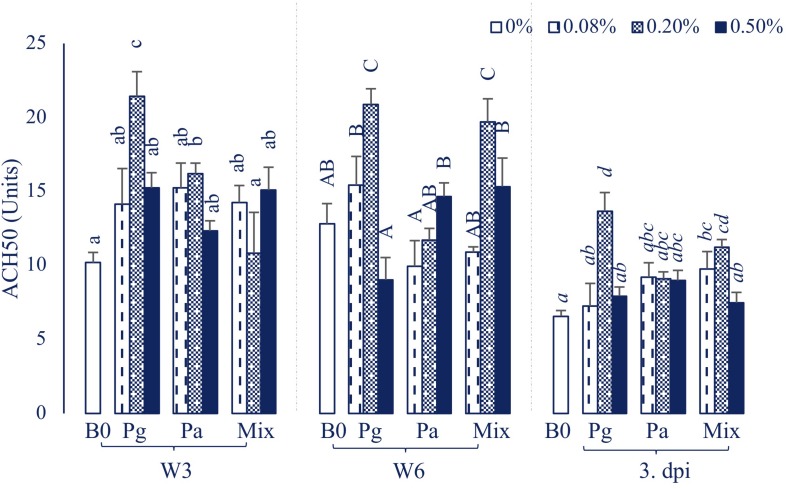
ACH50 activity in plasma of striped catfish fed extract-based diets supplemented with a single supply or a mixture of P. guajava and P. amarus at 0; 0.08; 0.2; and 0.5% after 3, 6 weeks and 3 dpi. B0, basal diet; Pg, P. guajava; Pa, P. amarus; Mix, Mixture of P. guajava and P. amarus; W3, week 3; W6, week 6; 3 dpi, 3 days post injection with E. ictaluri. Different letters indicate differences among diets at a given time point (p < 0.05). Values are means ± SEM, n = 3.